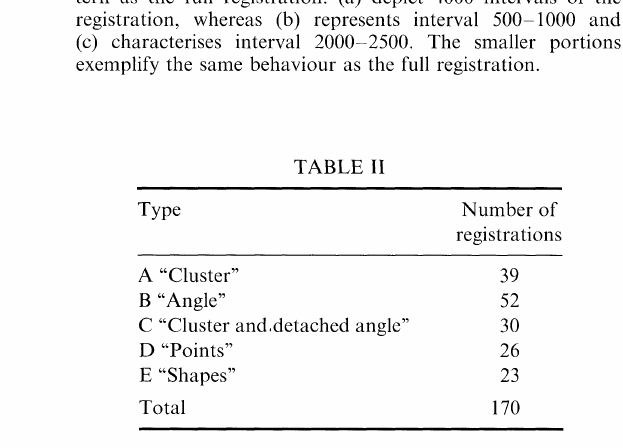
FIGURE 5 Excerpts of a full registration yield similar pat- tern as the full registration: (a) depict 4000 intervals of the registration, whereas (b) represents interval 500-1000 and (c) characterises interval 2000-2500. The smaller portions exemplify the same behaviour as the full registration.